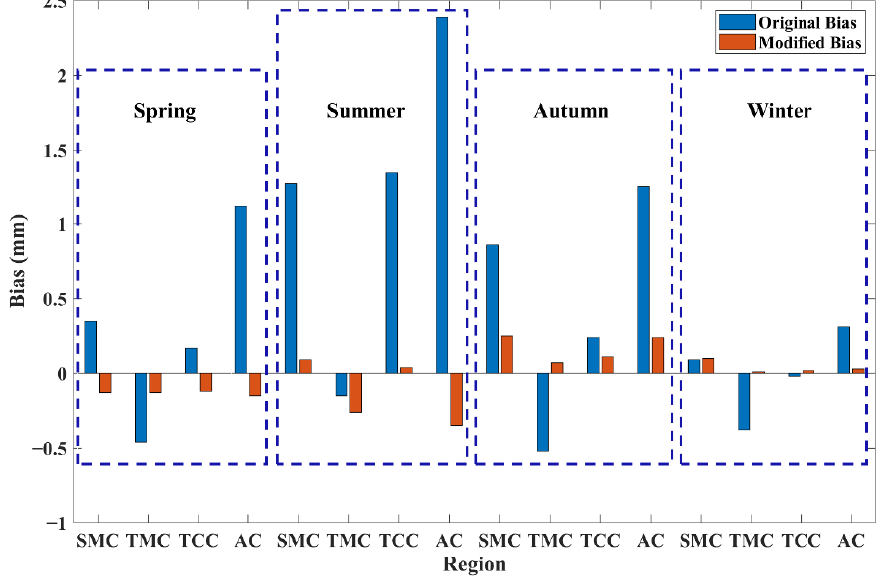
Figure 6. Comparison of the bias between the original ERA5 PWV and modified ERA5 PWV.